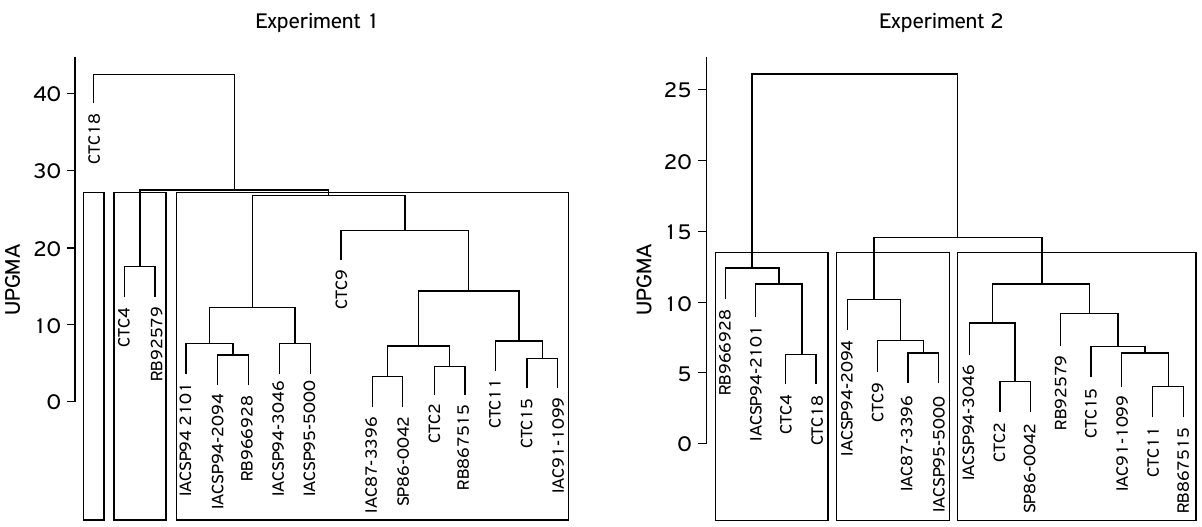
Figure 2. Dendrogram resulting from the grouping analyses, using the hierarchical cluster analysis (UPGMA) method, based on the Euclidian distance, from the parameters of technological quality, yield and damage of Diatraea saccharalis on 16 sugarcane